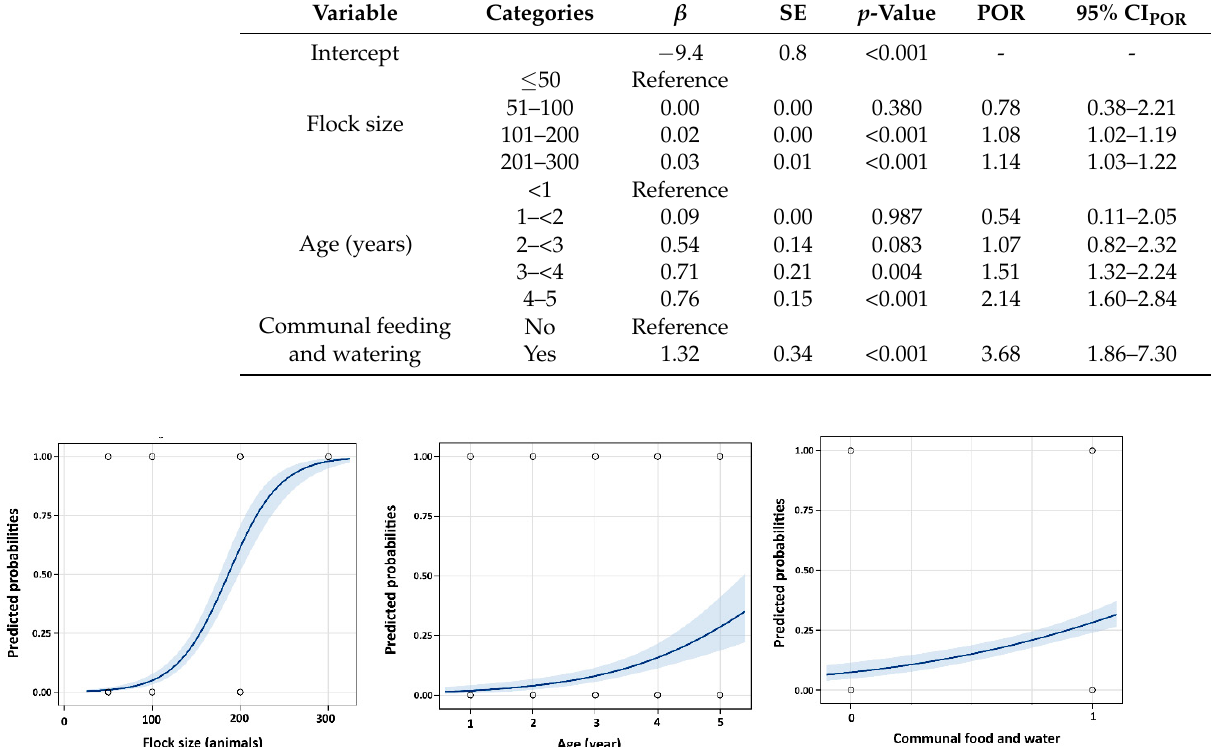
Table 2. Multiple stepwise logistic regression analysis of variables associated with sheep and goats that are positive with contagious caprine pleuropneumonia in the Nile Delta of Egypt.